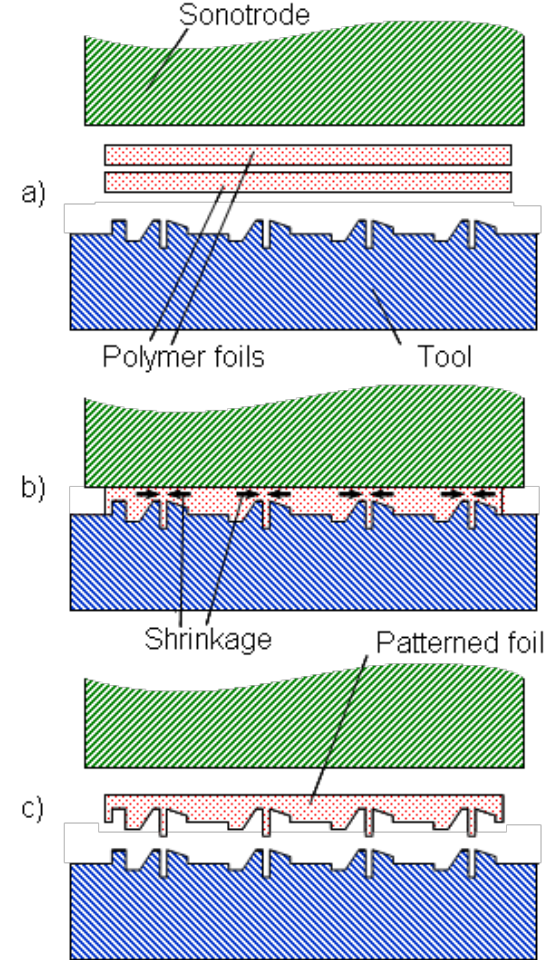
Figure 2. Schematic drawing of ultrasonic hot embossing: (a) Placing a stack of polymer foils on the tool; (b) Pressing the sonotrode onto the tool, applying ultrasound, and cooling down; (c)